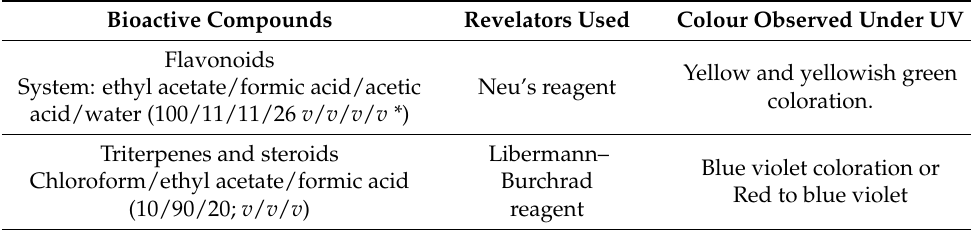
Table 1. Systems and revelators used for